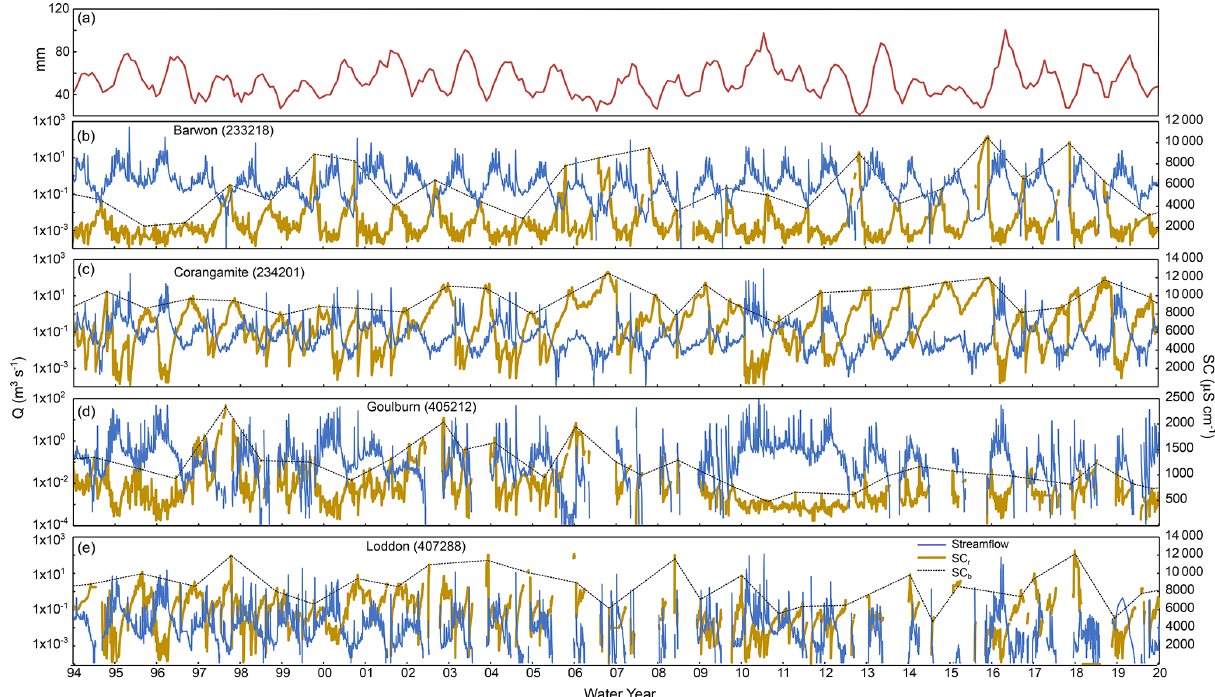
Figure 2. (a) Variations in rainfall (monthly running mean) in south-eastern Australia (data from the Barwon catchment, station 90008: Bureau of Meteorology, 2021). (b–e) Variation in streamflow ( Q ) and river SC (SC r ) for one station in the Barwon, Corangamite, Goulburn, and Loddon catchments (data from the Department of Environment, Land, Water and Planning, 2021). SC b is the SC of baseflow calculated by interpolation between annual maximum SC r values.